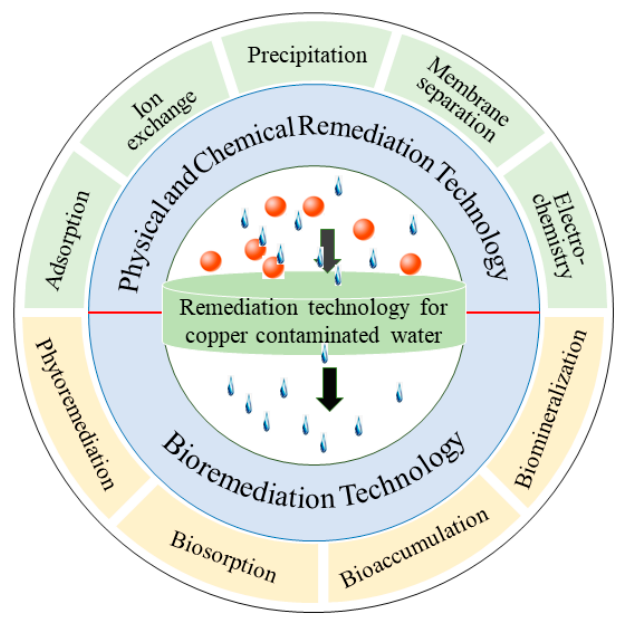
Figure 1. Treatment technology of Cu(II)-polluted